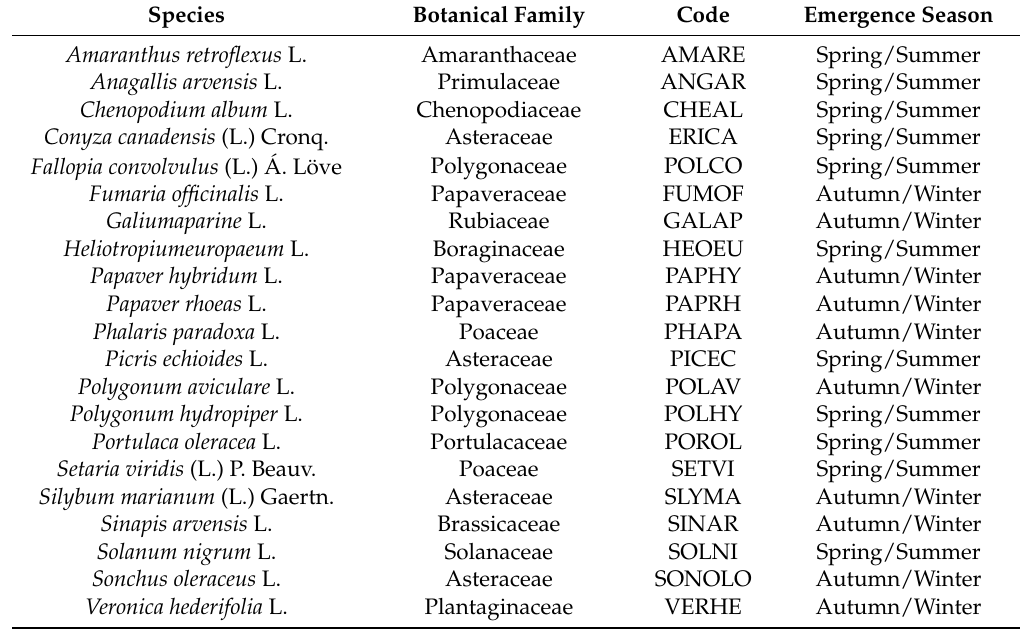
Table 1. Species recorded in the soil seed bank and their emergence season (1).